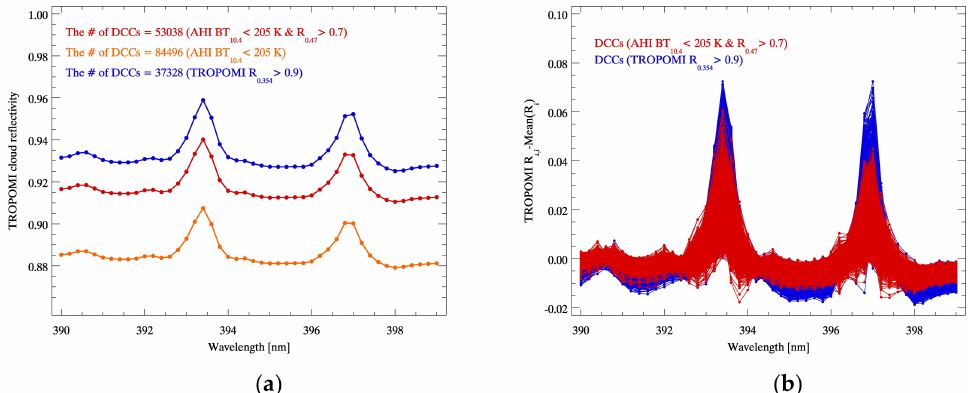
Figure 13. ( a ) Mean reflectivity and ( b ) anomaly spectra (i: each DCC pixel; λ : wavelength) of DCCs detected using di ff erent DCC detection threshold tests. The blue, red, orange lines represent the UV threshold test only, the updated DCC detection method, and the IR threshold test only, respectively. DCC measurements are from July 2018–June 2019 taken at five-day